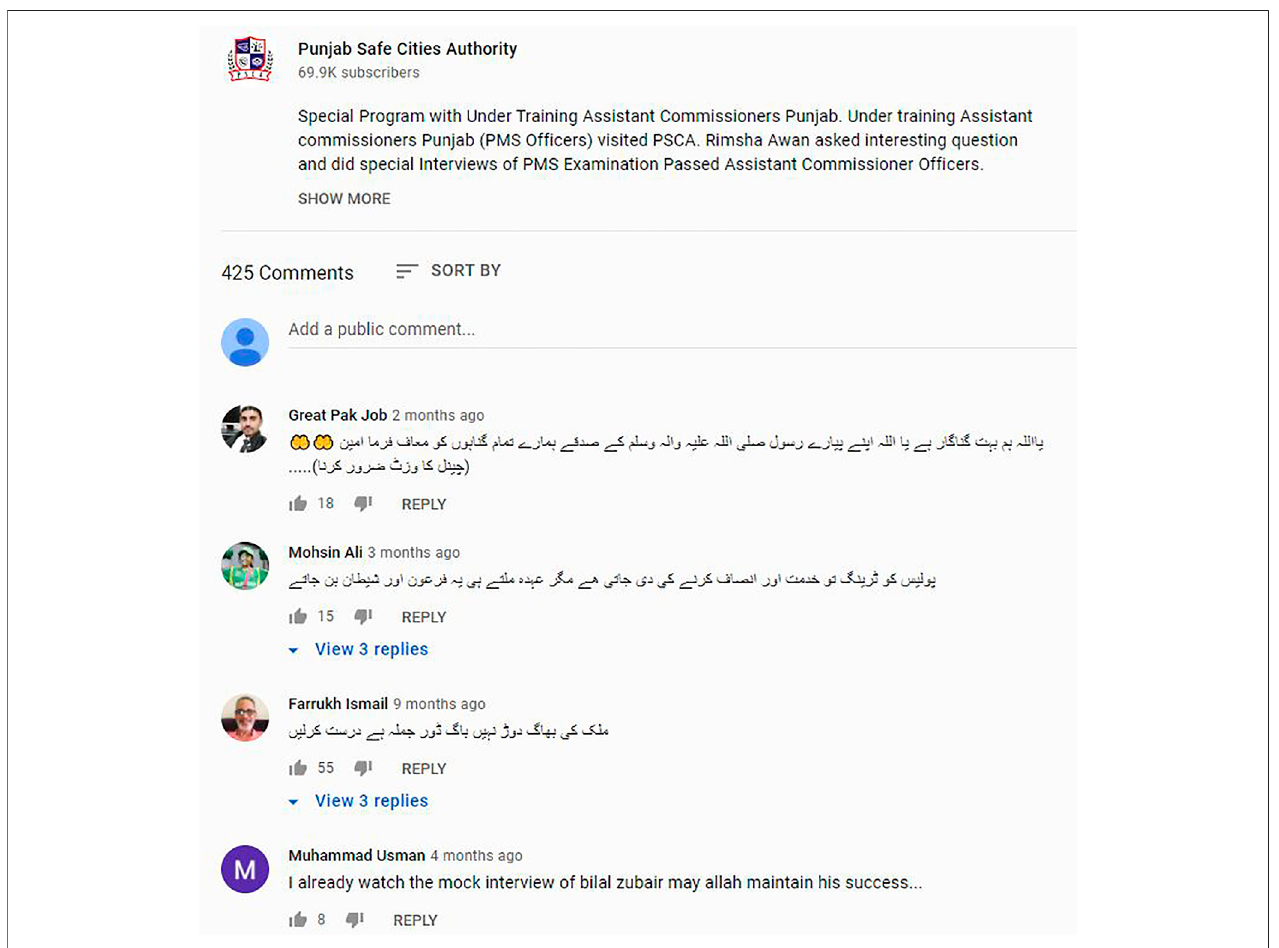
FIGURE 1 | YouTube comments. (Publicly